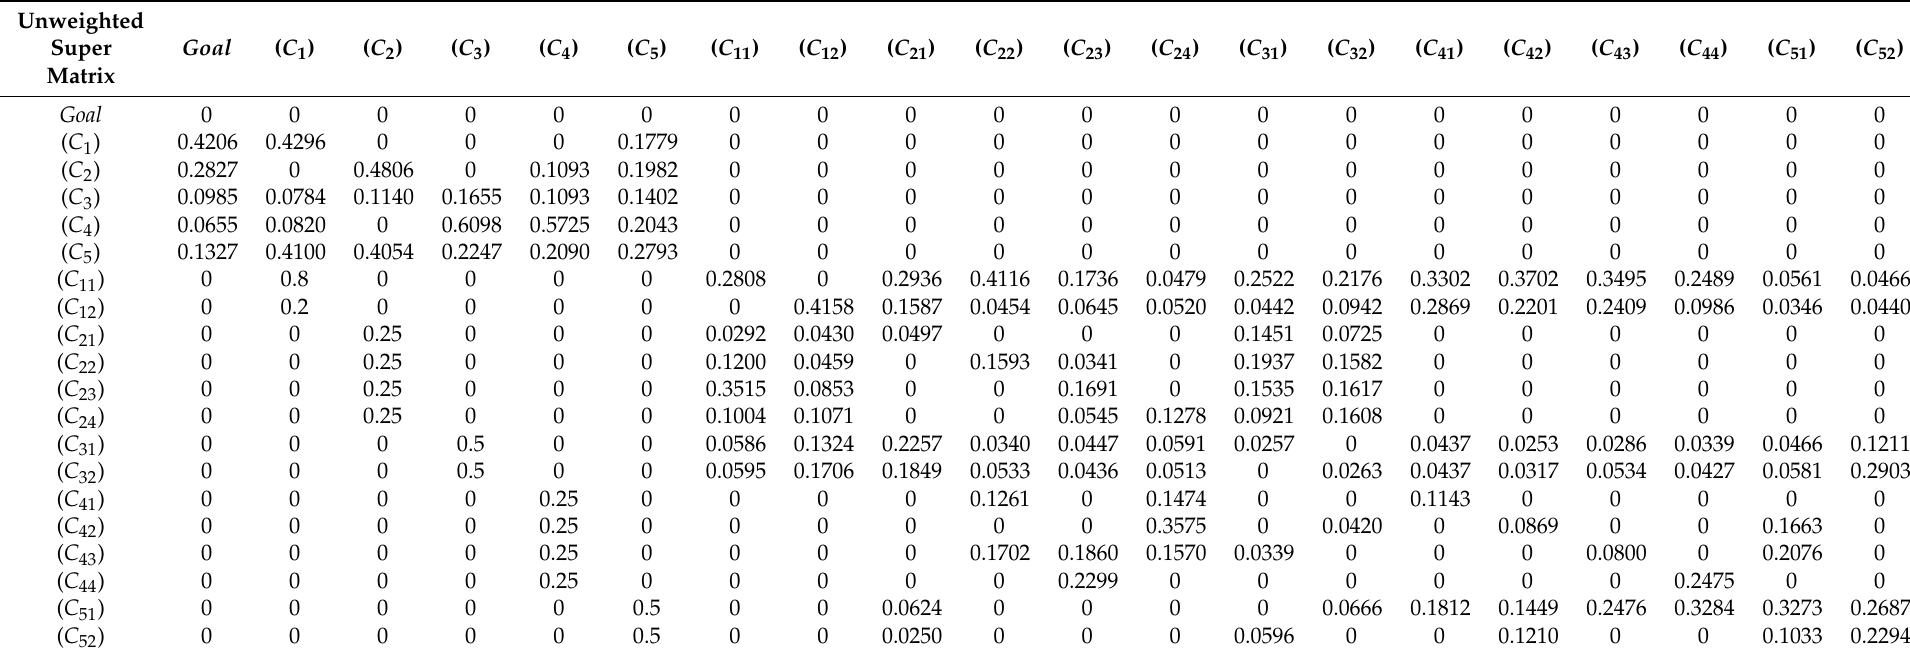
Table 8. Unweighted